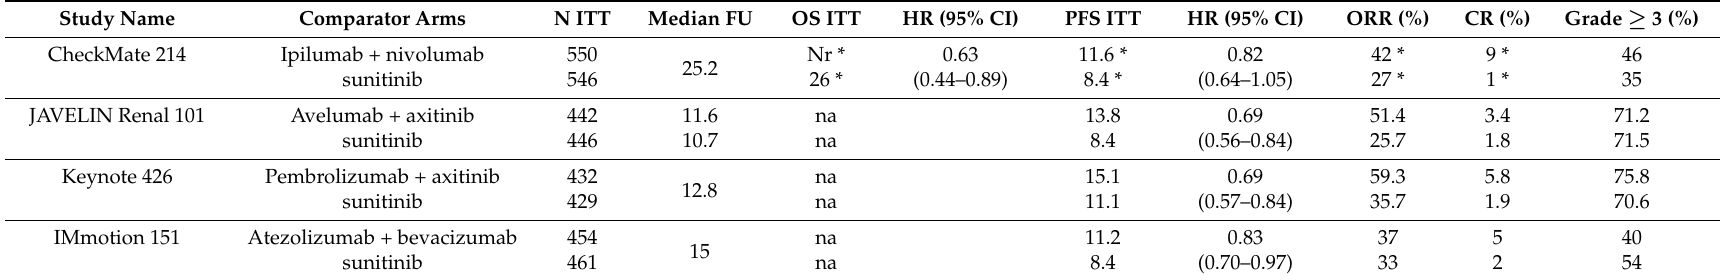
Table 3. Comparison of pivotal phase III clinical trials with available results evaluating immune checkpoints